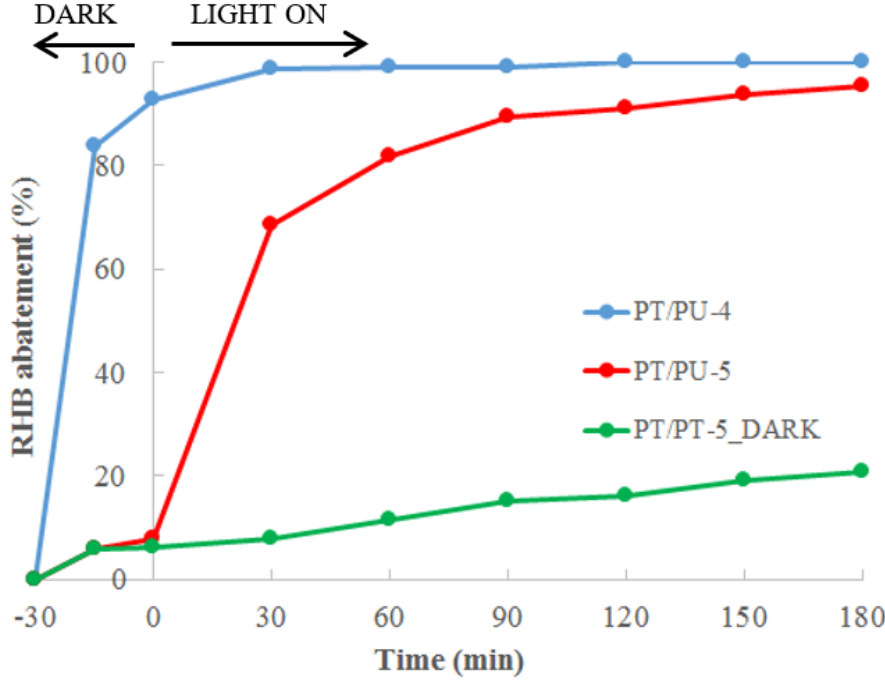
Figure 5. Percentage of RHB abatement tests using PT/PU-4 and -5.